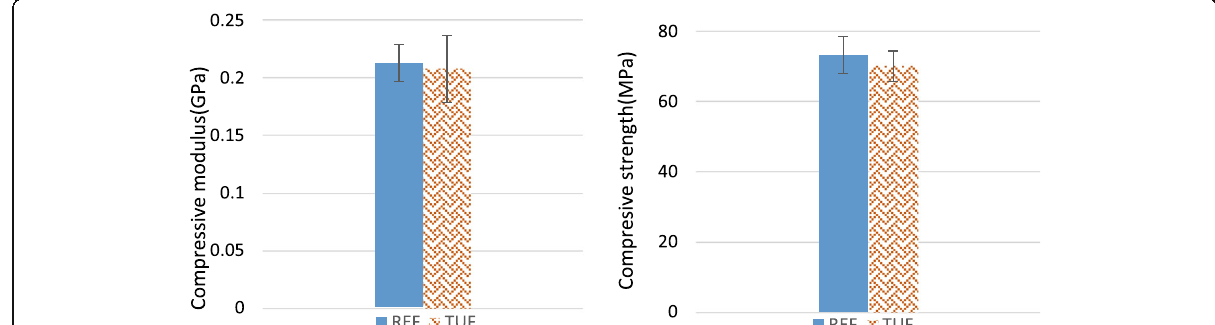
Fig. 13 a Ultimate compressive strength and b Compressive modulus for REF and TUF green